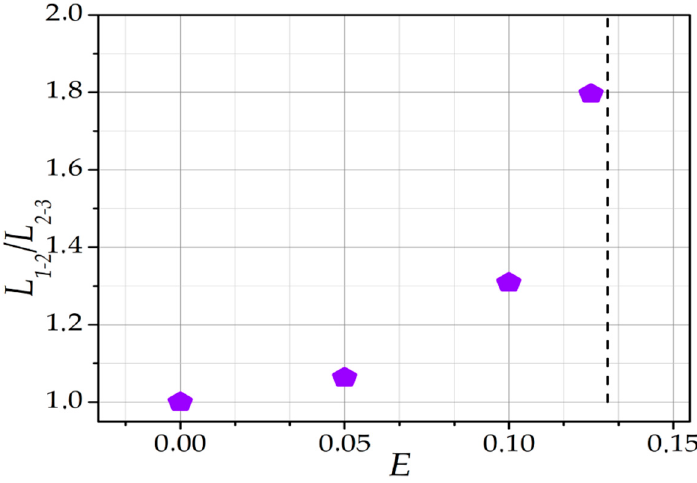
Figure 7. Dependence of the ratio L 1-2 / L 2-3 on the external electric field E . F ext = − 0.2, l i = 5.